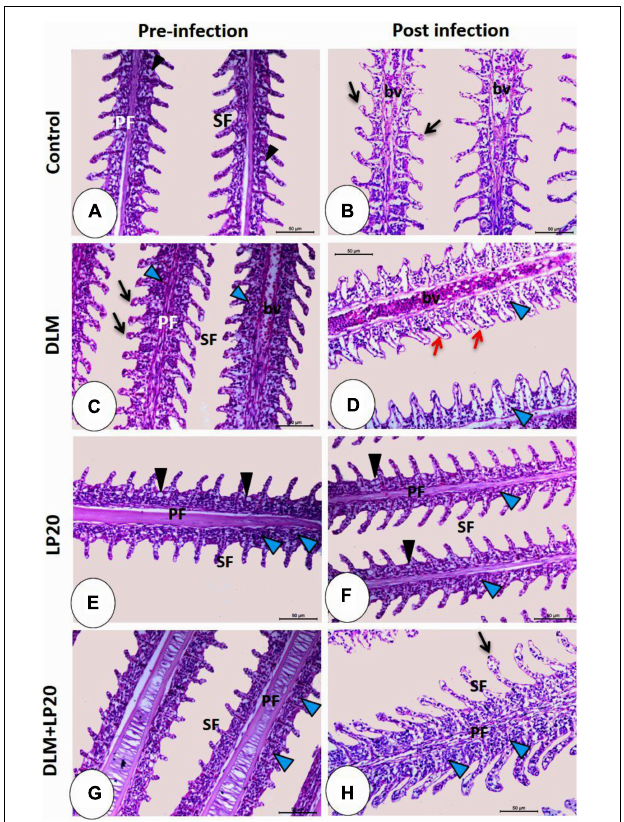
FIGURE 6 | Histomicrograph of gills of Nile tilapia subjected to four treatments (control, DLM, LP20, and DLM + LP20) before (A,C,E,G) and after (B,D,F,H) infection. In panels (A,E,G) , the gills show normal histological structures including primary filaments (PF), secondary filaments (SF), and mucous cells (black arrowhead) between the secondary filaments. The toxic effect of DLM (C) causes telangiectasia (black arrow) of the secondary filaments, congestion of blood vessels (bv) of primary filaments, and leukocytic cell infiltration (blue arrowhead). In the post-infected groups, the histopathological effect became more severe in the DLM group [the red arrow in panel (D) refers to degeneration and separation of the secondary epithelium] followed by the control group, while panels (F,H) showed normal histological structures due to the effect of LP20. Stain H&E. Bar = 100 µ m.